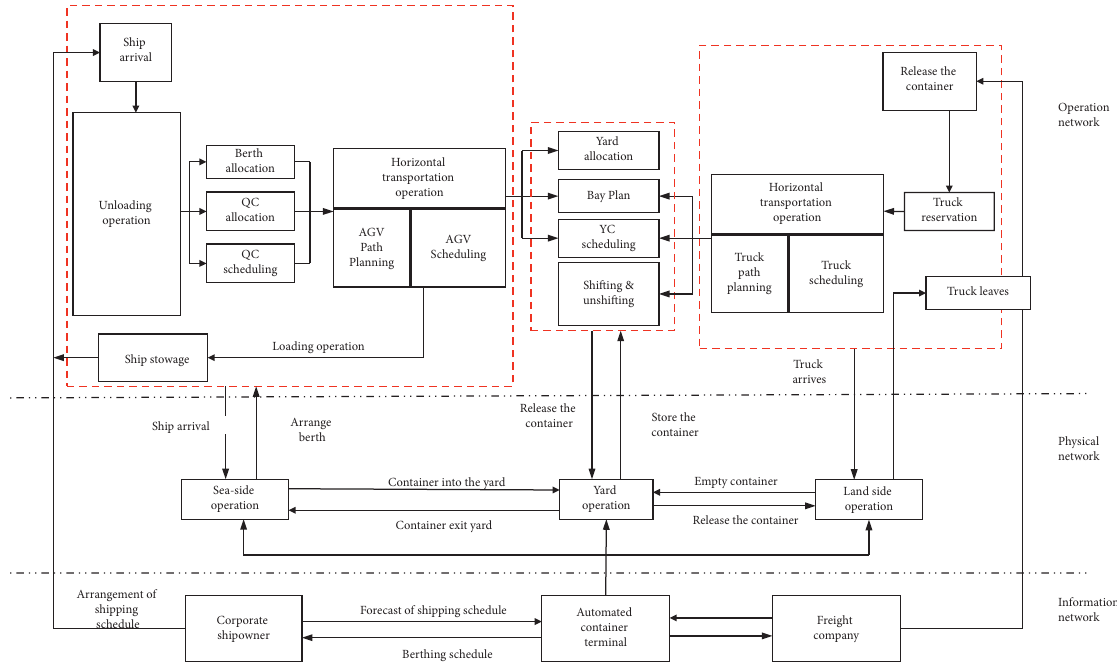
Figure 1: Schematic diagram of container terminal